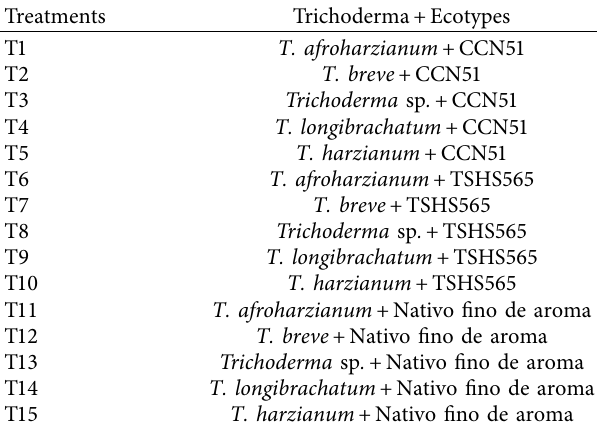
Table 1: Description of